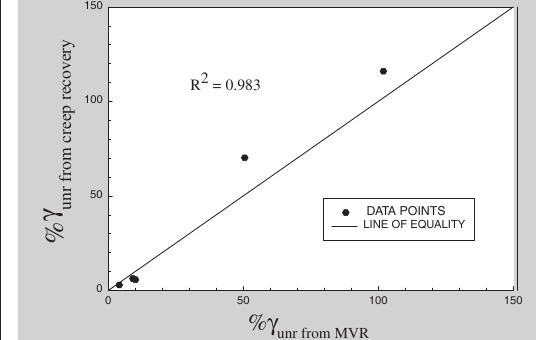
Figure 20 : Comparison of the %-unrecovered strain obtained from creep recov- ery experimental data with that obtained by calcula- tions using MVR data from the